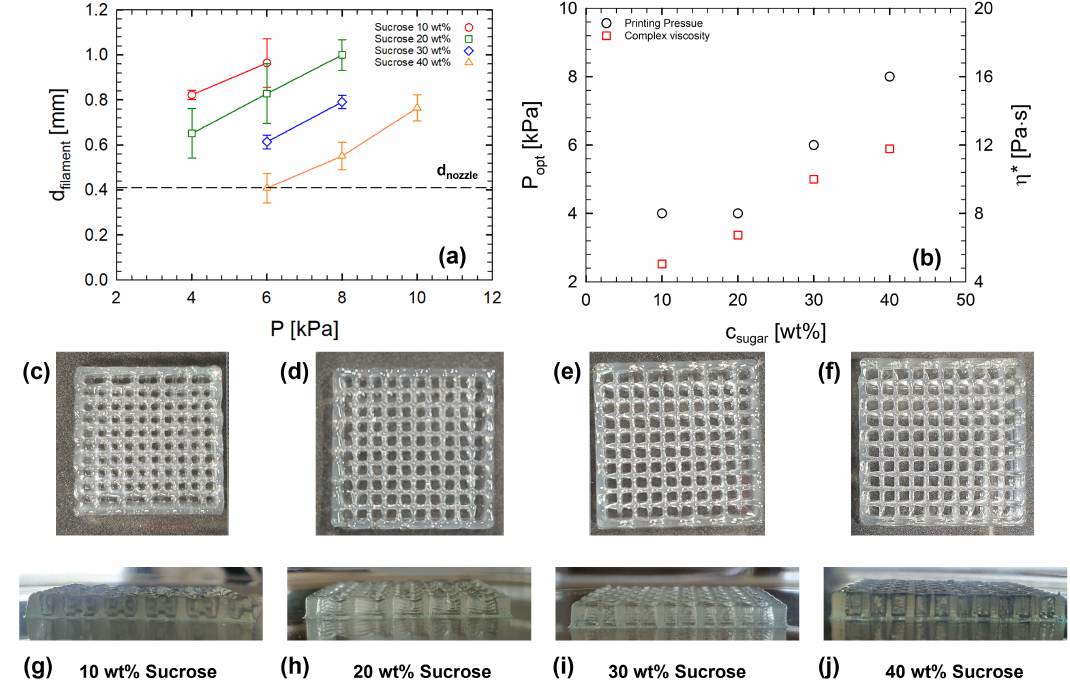
Figure 13. ( a ) Filament diameter as a function of the printing pressure, for samples with 1.5 wt% κ -c and 1.3 wt% XG, at different sucrose levels. Error bars result from different measurements. ( b ) Optimized printing pressure (left y-axis) and complex viscosity, evaluated at T onset + 10 ◦ C from data shown in Figure 10a (right y-axis), as functions of sucrose concentration, for samples with 1.5 wt% κ -c and 1.3 wt% XG. Snapshots of the frontal area ( c – f ) and side area ( g – j ) of the printed grids extruded under best pressure